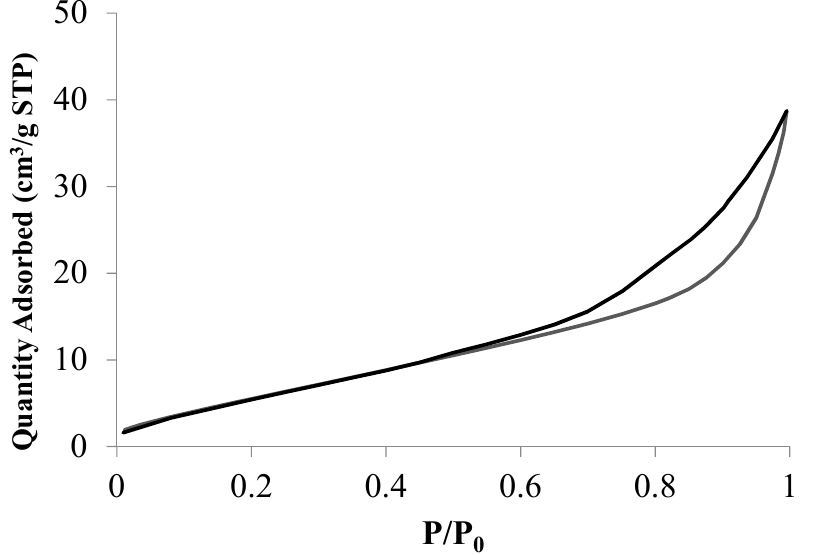
Figure 2. Representative adsorption–desorption isotherm of N 2 for the sample synthesized when using PEO as surfactant.